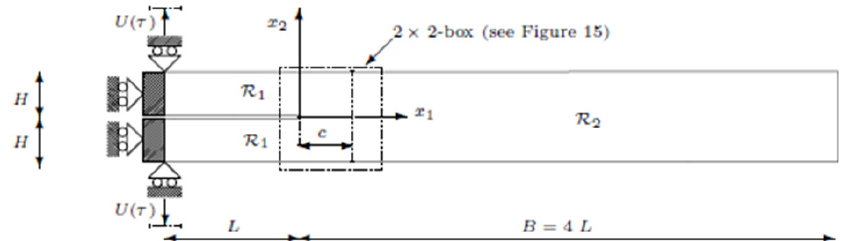
Figure 8: Plane strip with a straight crack in mode I, hard device. The boxed area is the square that is zoomed in